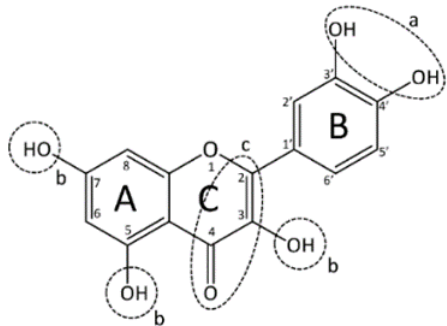
Figure 2. Antioxidant structure and activity relationships of flavonoids .